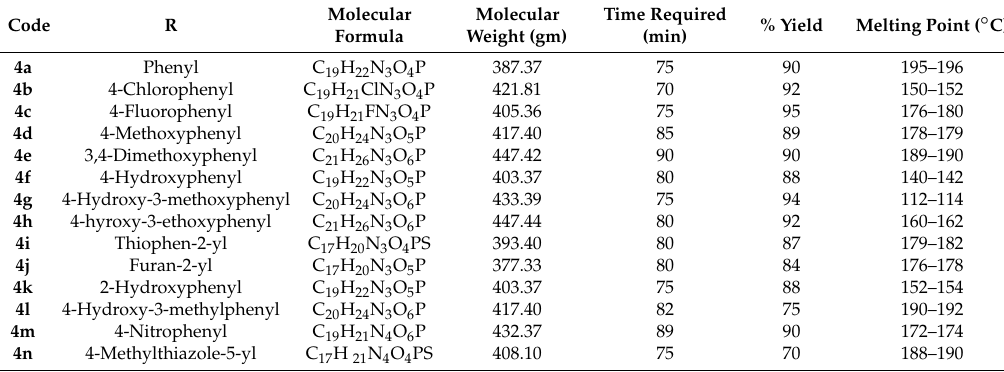
Table 1 . Physical constant data for diethyl (substitutedphenyl/hetery)(2-(2-oxoindolin-3-ylidene) hydrazinyl)methylphosphonates 4 ( a – n ).